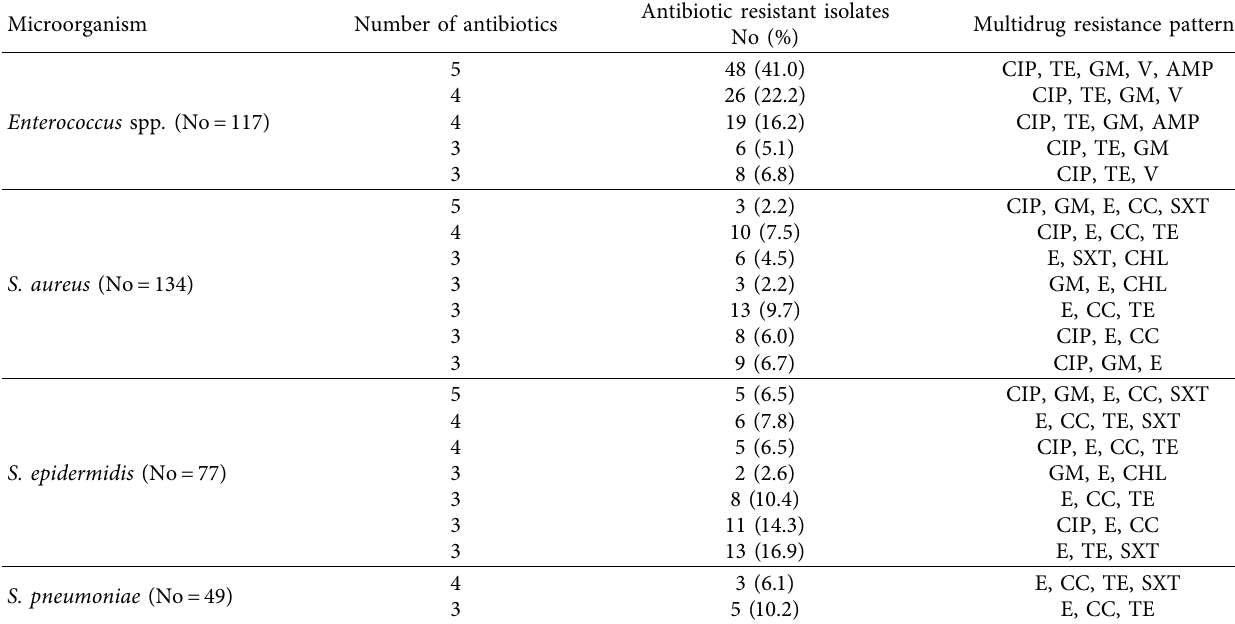
Table 6: Multidrug resistance patterns of Gram-positive bacteria isolated from patients with infections. Antibiotic resistant isolates Microorganism Number of antibiotics